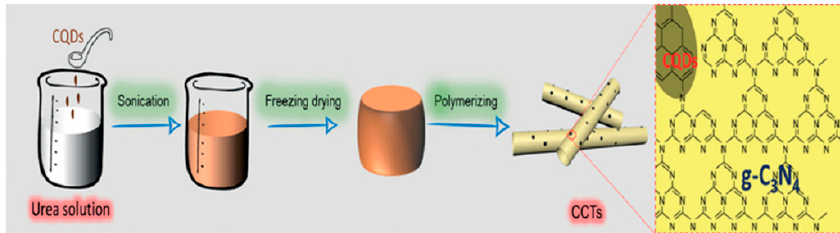
Figure 6. CCTs preparation procedure (reproduced with permission from [101]. Copyright Wiley-VCH, 2018).